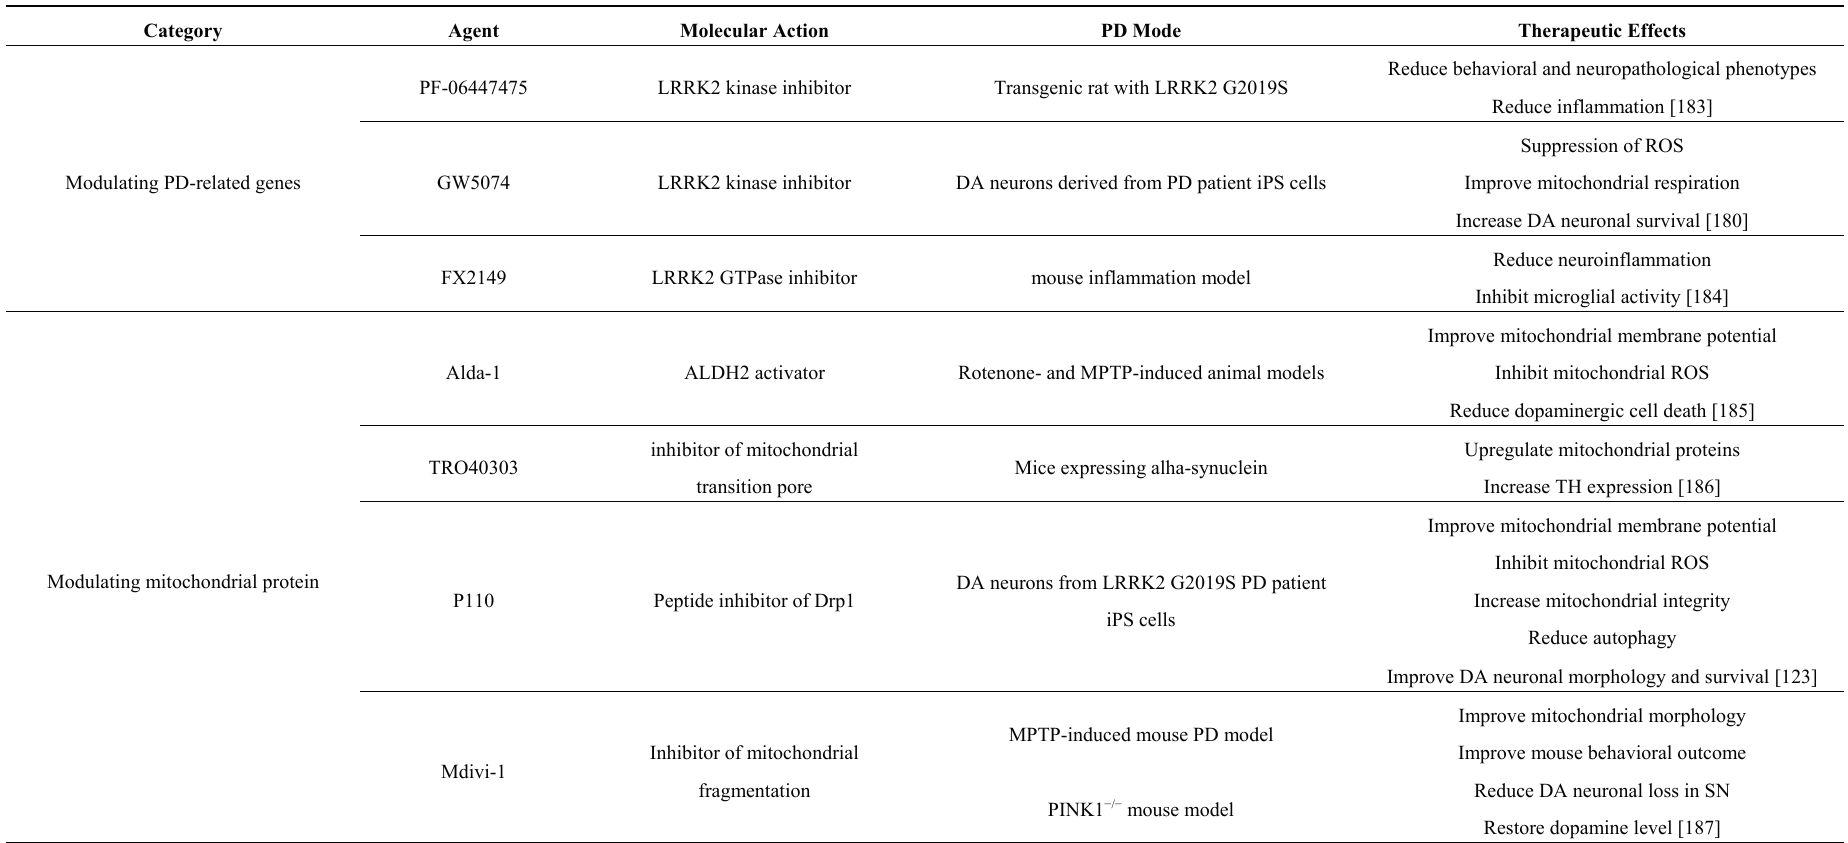
Table 2. Therapeutic agents that target mitochondria for treatment of Parkinson’s